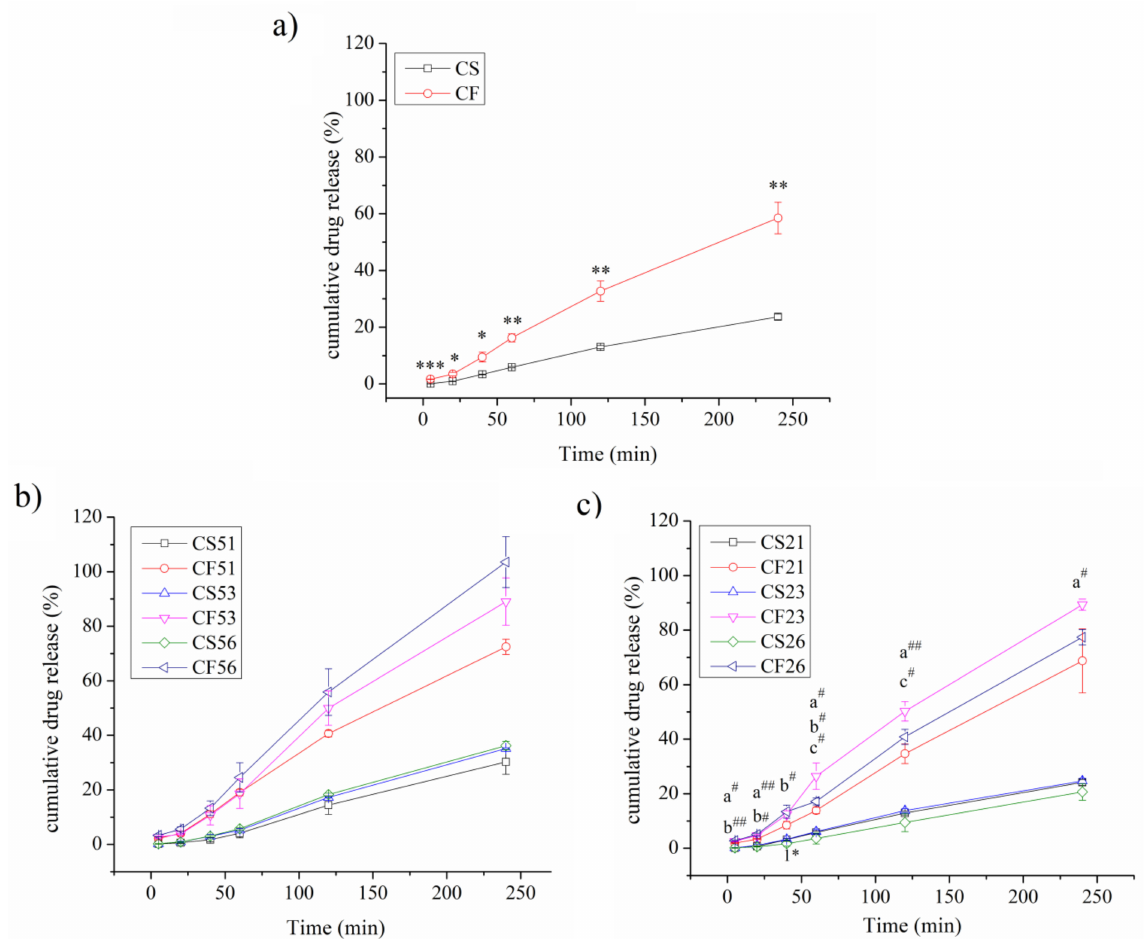
Figure 7. Cumulative release of curcumin from ( a ) non-PEGylated formulations with soybean oil (CS) and fish oil (CF); ( b ) NEs with PEG2000-DSPE containing soybean oil (CS21, CS23, and CS26) or fish oil (CF21, CF23, and CF26); ( c ) NEs with PEG5000-DPPE containing soybean oil (CS51, CS53, and CS56) or fish oil (CF51, CF53, and CF56); values are shown as means ± sd ( n = 3); *, **, and ***, p < 0.05, p < 0.01, and p < 0.001 compared to CS; a # p < 0.05, a ## p < 0.01, CF21 vs. CF23; b # , b ## , p < 0.05 and p < 0.01 CF21 vs. CF26; c # p < 0.05, CF23 vs. CF26; 1* p < 0.05, CS23 vs.